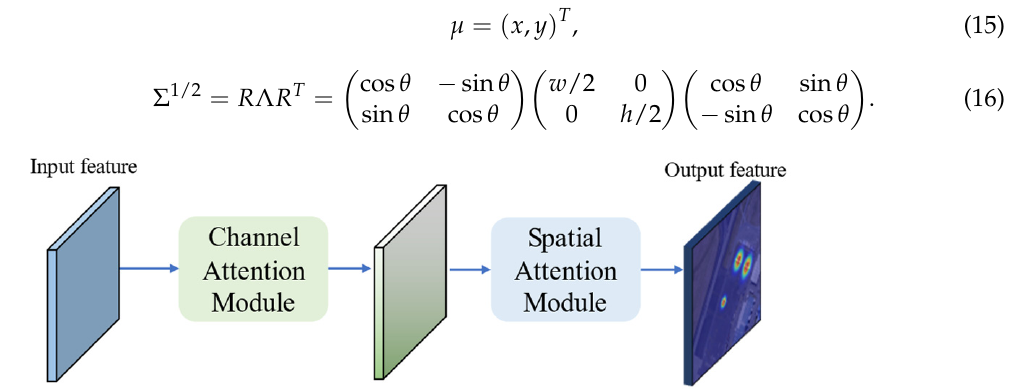
Figure 4. Illustration of the KAM.